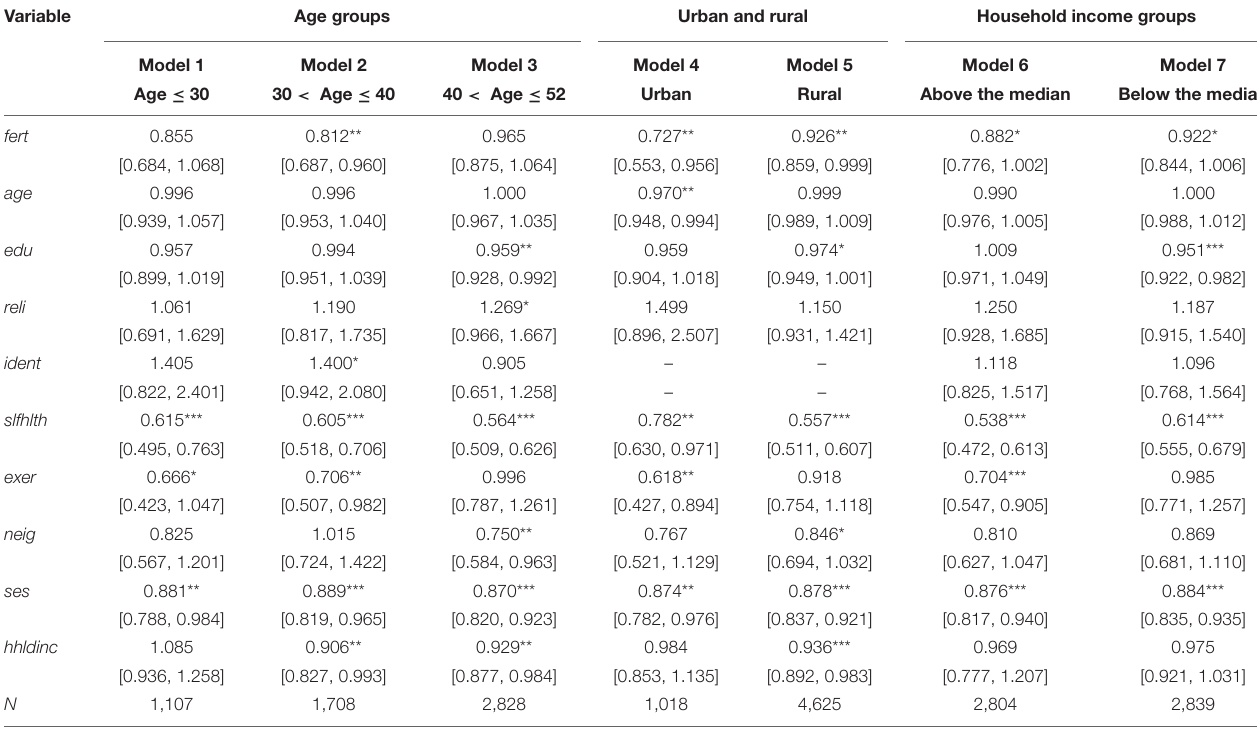
TABLE 3 | Estimates of heterogeneity analysis: age groups, urban and rural, and household income groups.